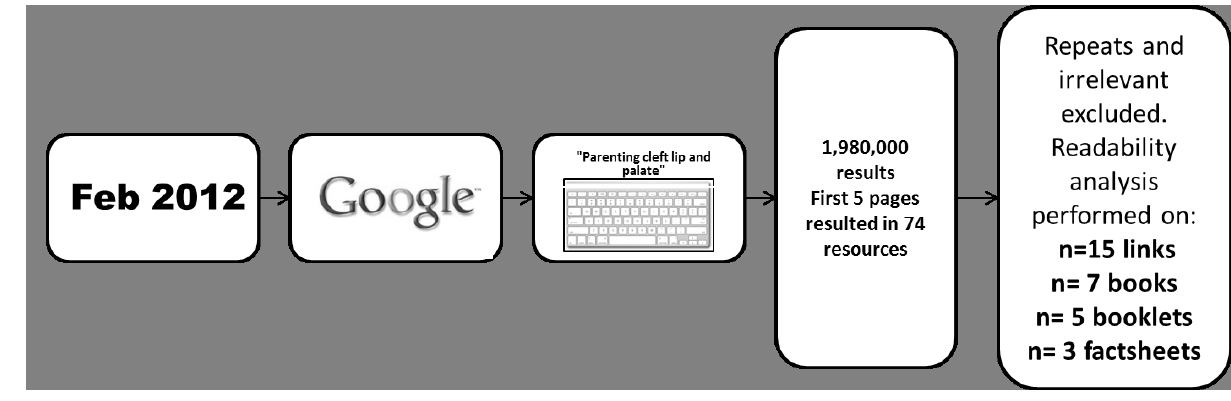
Figure 1. Diagram of data